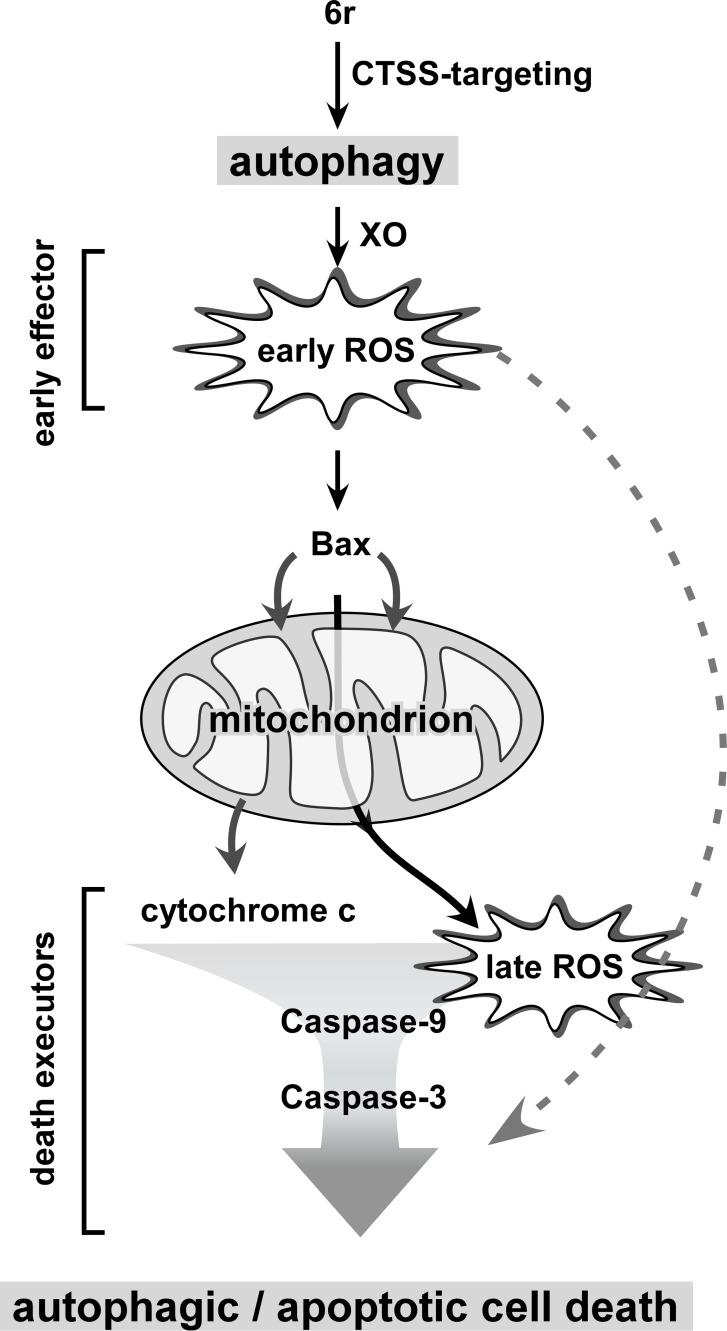
Conclusion model of autophagy-regulated early ROS in the connection between death autophagy and apoptosis.In CTSS-targeting cells, autophagy is quickly activated to regulate XO for the first oxidative burst (early ROS generation). The harmful early ROS can subsequently act as an early effector to for triggering Bax activation and subsequently causing cytochrome c release, and mitochondrial membrane depolarization for the second oxidative burst. Consequently, these factors act as death executors for the triggering of mitochondria-dependent apoptosis. Thus, these dying cells simultaneously display mixed autophagic and apoptotic hallmarks. When upstream autophagy and/or early ROS level are attenuated, mitochondria-dependent apoptotic signaling cascades diminish.